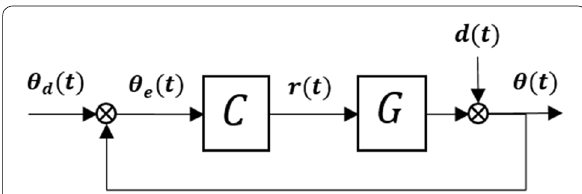
Fig. 7 Active control block diagram. The pitch stabilization control flow is shown in this figure. The control plant G consists of the whole structure of buoy together with stabilization mechanism. θ and θ d are the observed and the desired pitch angle (i.e., zero degree) of the buoy, respectively. The controller C gets the pitch deviation θ e and sends the proper linear displacement r of the slider to the G . Wave induced external forces are input as a distubance d to the system